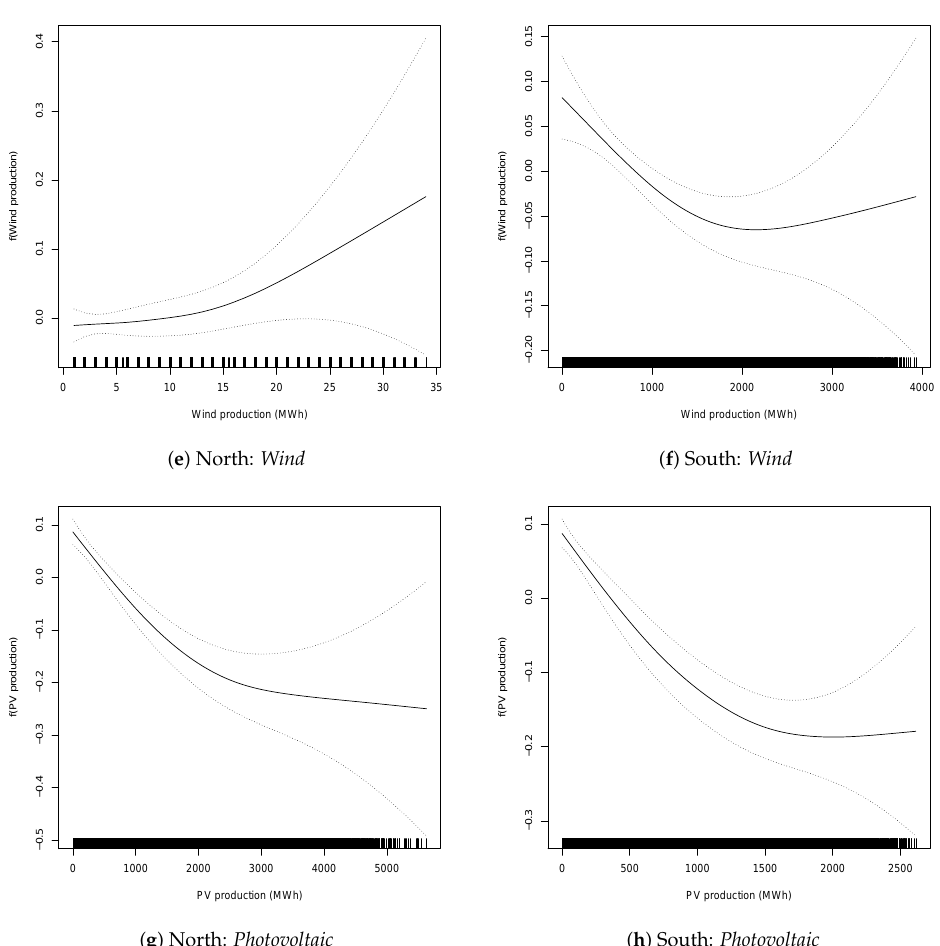
Figure 6. In-sample estimation results of the non-parametric additive model for the conditional variance of electricity prices. For both zones, each panel plots the estimated function h j ( · ) for the prices, demand and thermal production.